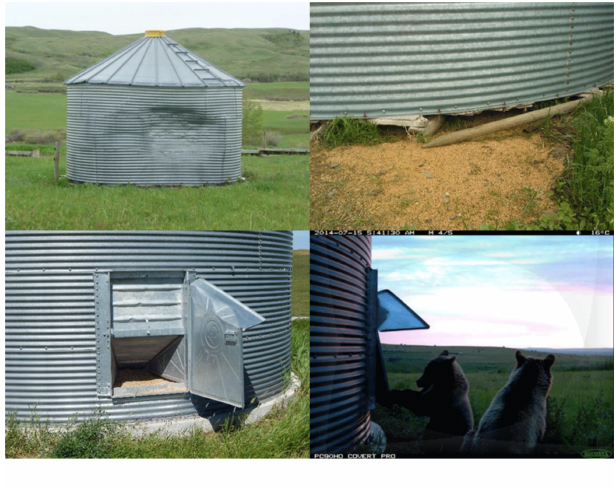
Fig. 7 . Examples of grain bin damage caused by grizzly bears ( Ursus arctos ) in our study area. Photo credits clockwise from top left are Andrea Morehouse, Nora Manners, Alberta Environment and Parks/Waterton Biosphere Reserve Association remote trail camera, Spencer